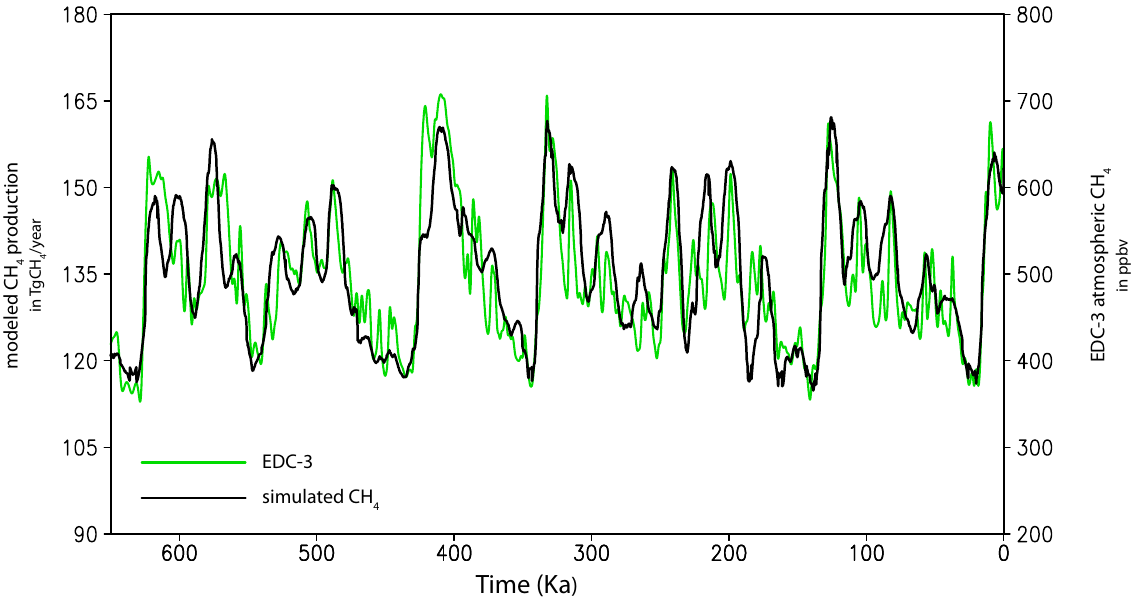
Fig. 5. Epica Dome C atmospheric CH 4 concentrations (green line; in ppbv; Loulergue et al,. 2008), low pass filtered for timescales longer than 3Kyr, and TRENCH simulated annual global CH 4 emissions (black line; in TgCH 4 .